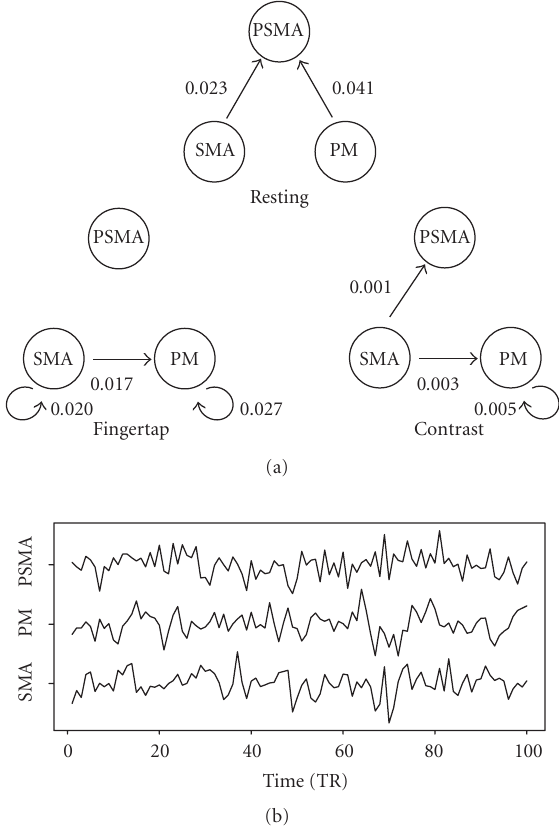
Figure 2: Group connectivity structure during resting, fingertap- ping, and information flow changes between these two conditions (top). The numbers in the arrows describe the information flow cor- respondent P value. An illustrative chart of ROI’s BOLD signals of one subject is also